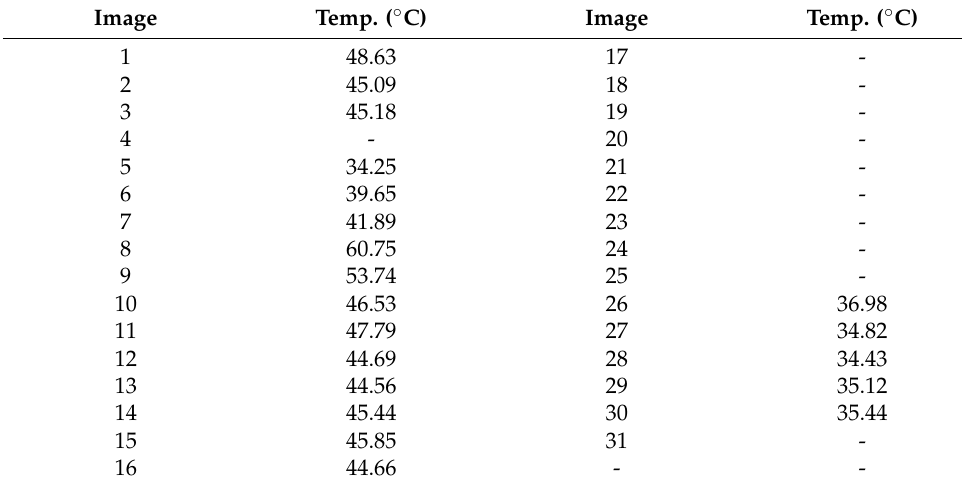
Table 2. Maximum temperature recorded in each of the thermographs. Image Temp. ( ◦ C) Image Temp. ( ◦ C)